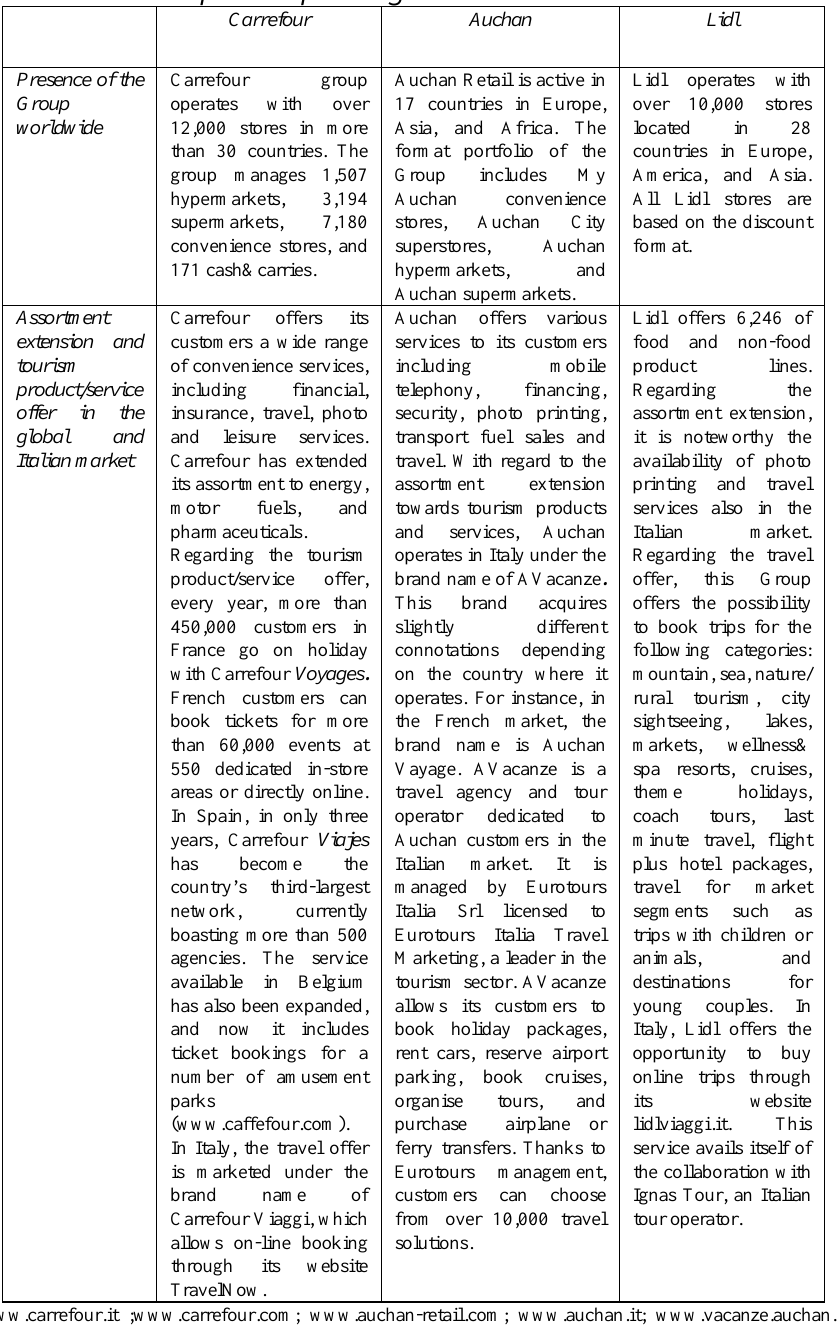
Table 3: Assortment extension and travel offer of foreign-owned large-scale retailers companies operating on the Italian